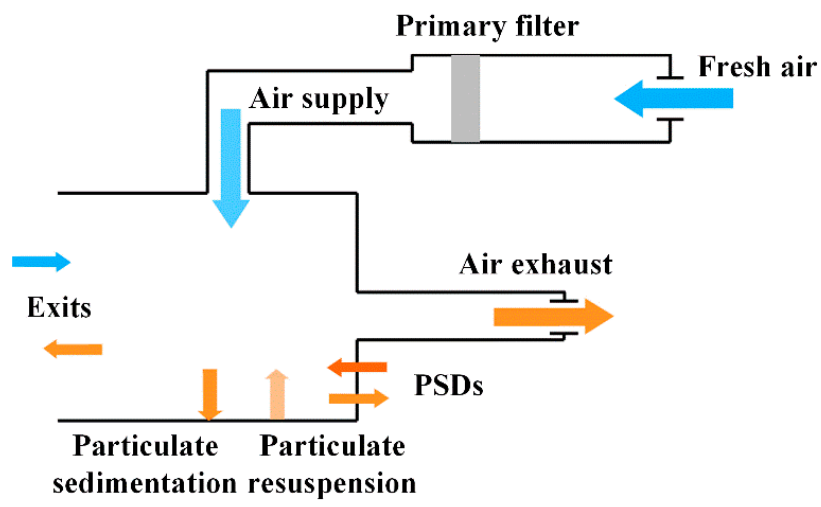
Figure 5. Simplified diagram of ventilation in the station during the non-air-conditioning season.